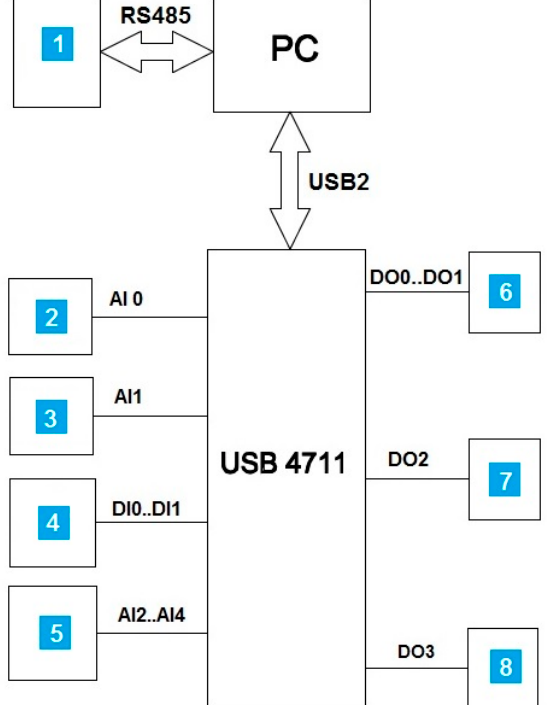
Figure 7. Block diagram of the laboratory control system: 1—seed counting unit, 2—seed weighing unit, 3—weighing unit of the main tank, 4—carriage position sensor, 5—pressure sensor, 6—carriage drive servomotor, 7—fan drive, 8—sowing plant drive.